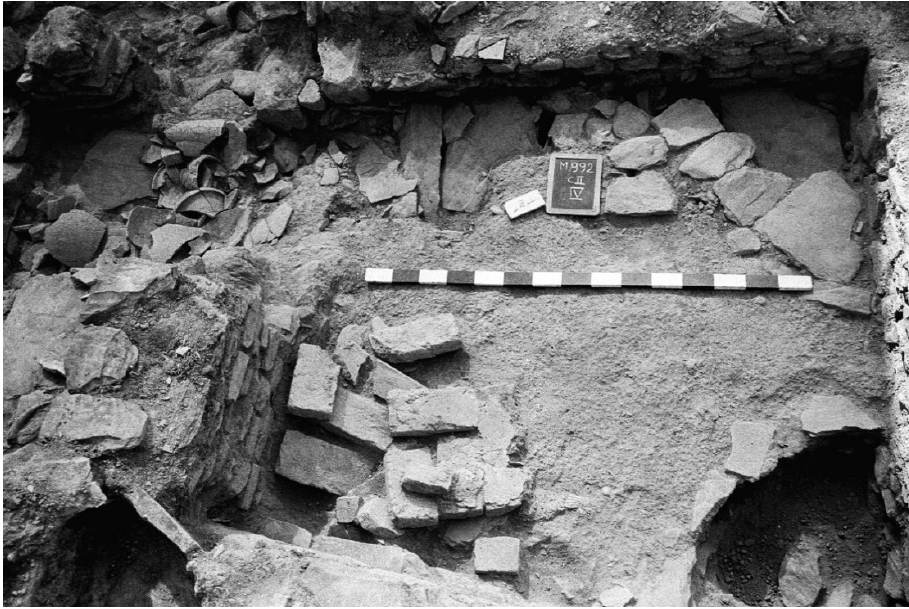
Figure 12. Mértola—house n. 2 (kitchen—hearth place). Photo took by author.